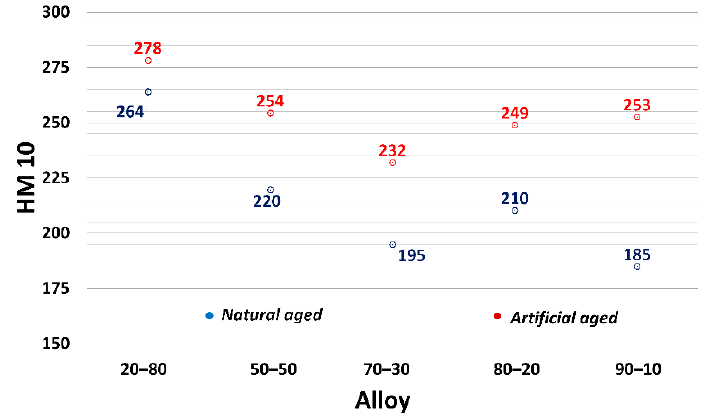
Figure 16. Substructure of 90–10 alloy focus on θ ’-Al 2 Cu phases, TEM; ( a ) natural aging, ( b ) artificial aging. artificial aging.